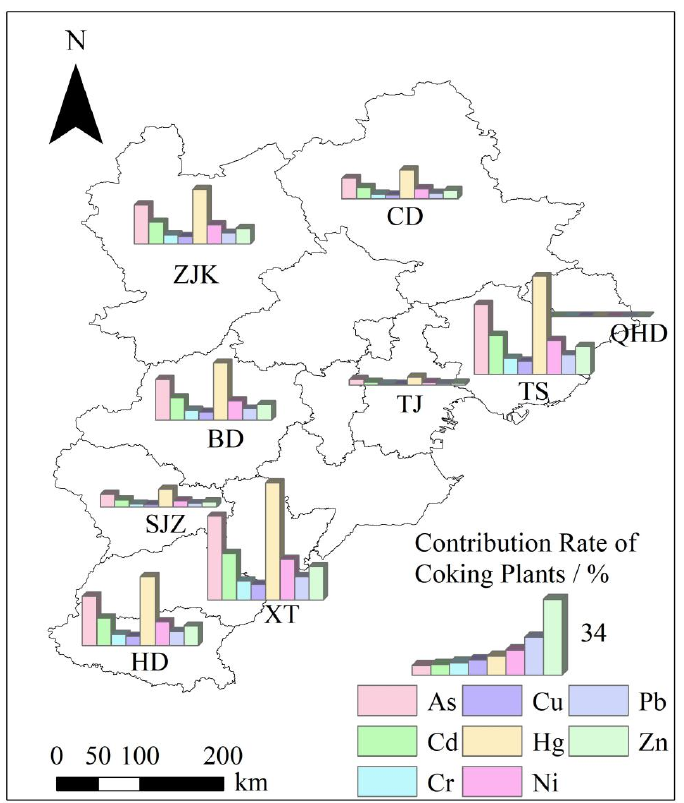
Figure 2. Contribution rate of coking plants to the PHE discharge in BTH. ZJK indicates Zhangjiakou, CD indicates Chengde, BD indicates Baoding, TJ indicates Tianjin, TS indicates Tangshan, QHD indicates Qinhuangdao, SJZ indicates Shijiazhuang, XT indicates Xingtai, and HD indicates Handan.